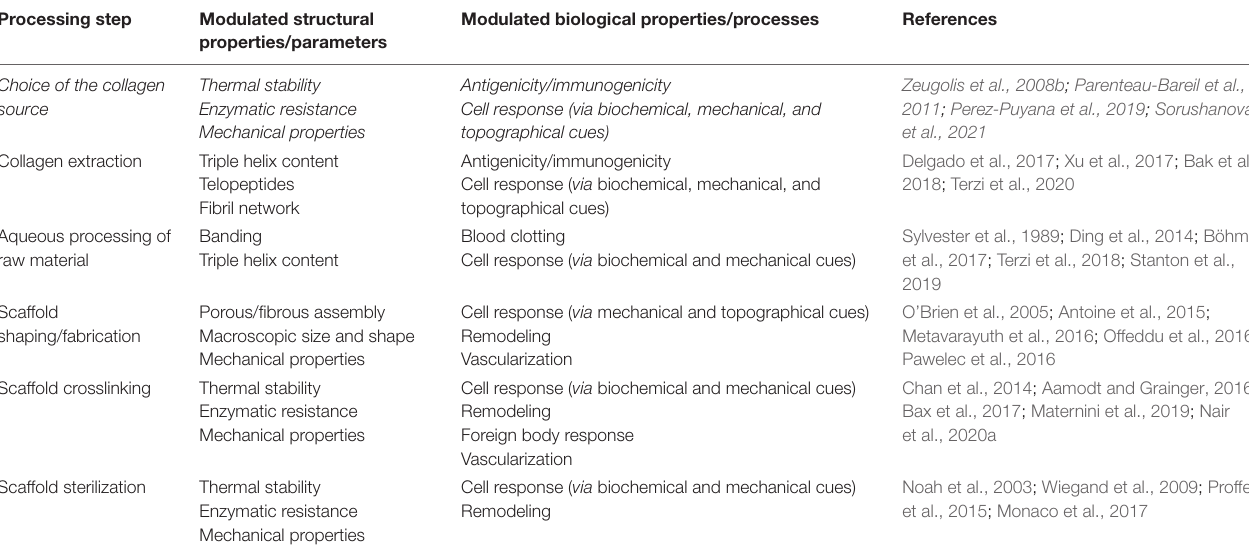
TABLE 3 | Impact of processing on the structure-related biological activity of collagen-based scaffolds: overview of the main structural properties (or parameters) modulated by a given processing step and the in vitro/in vivo biological properties (or processes) that could be concurrently